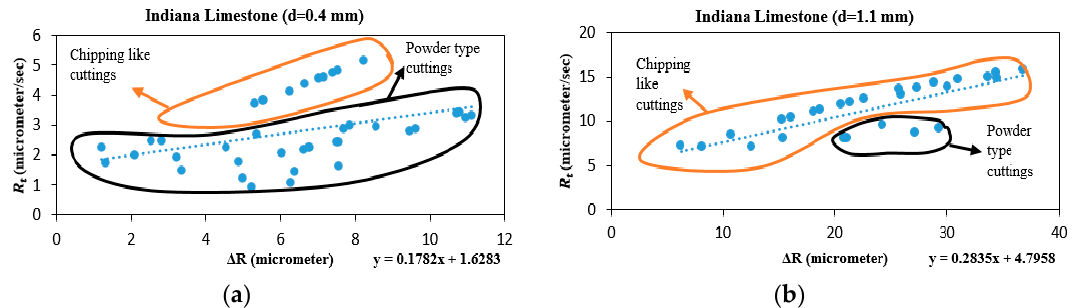
Figure 23. Evolution of chunk like cuttings and powder cuttings at different DOCs: ( a ) d = 0.4 mm; ( b ) d = 1.1 mm.